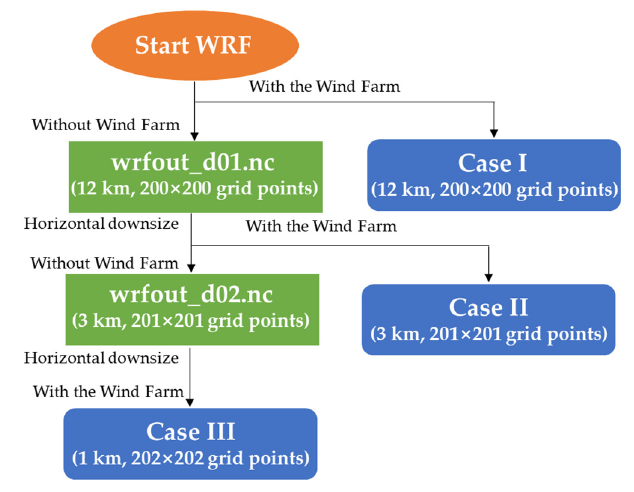
Figure 4. The flow chart of the experiments in the research.